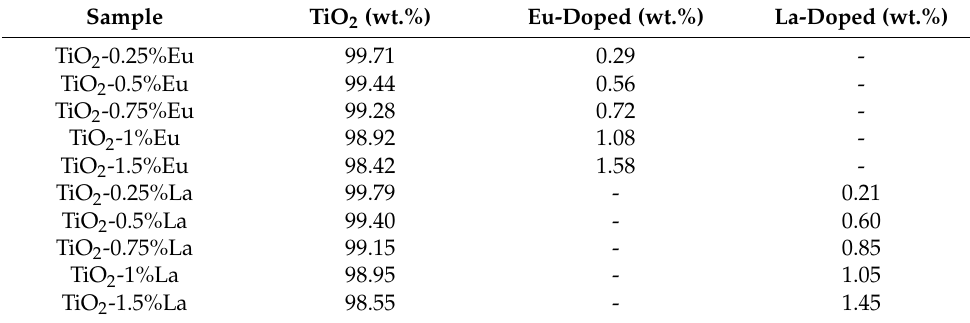
Table 3. The results of EDXRF analysis for TiO 2 -La and TiO 2 -Eu systems.